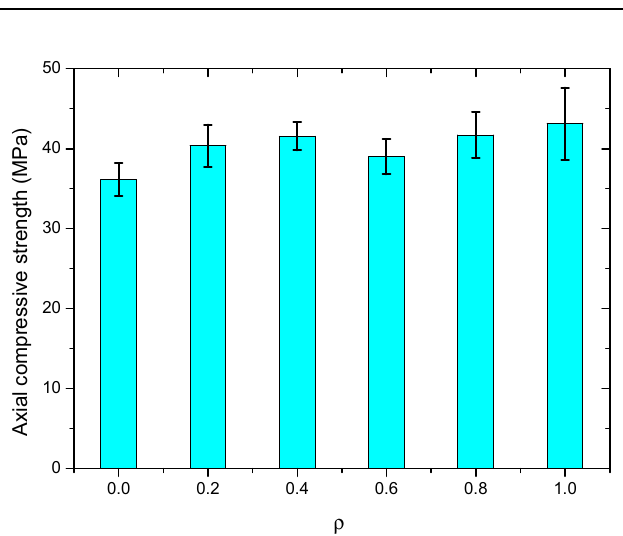
Figure 14. f c of SWSSC specimens with different ρ .